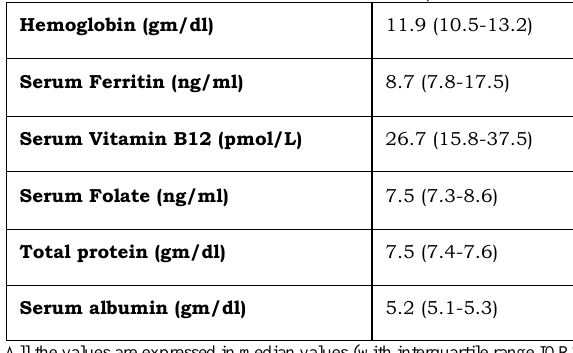
Table 3: Blood test values at last follow up